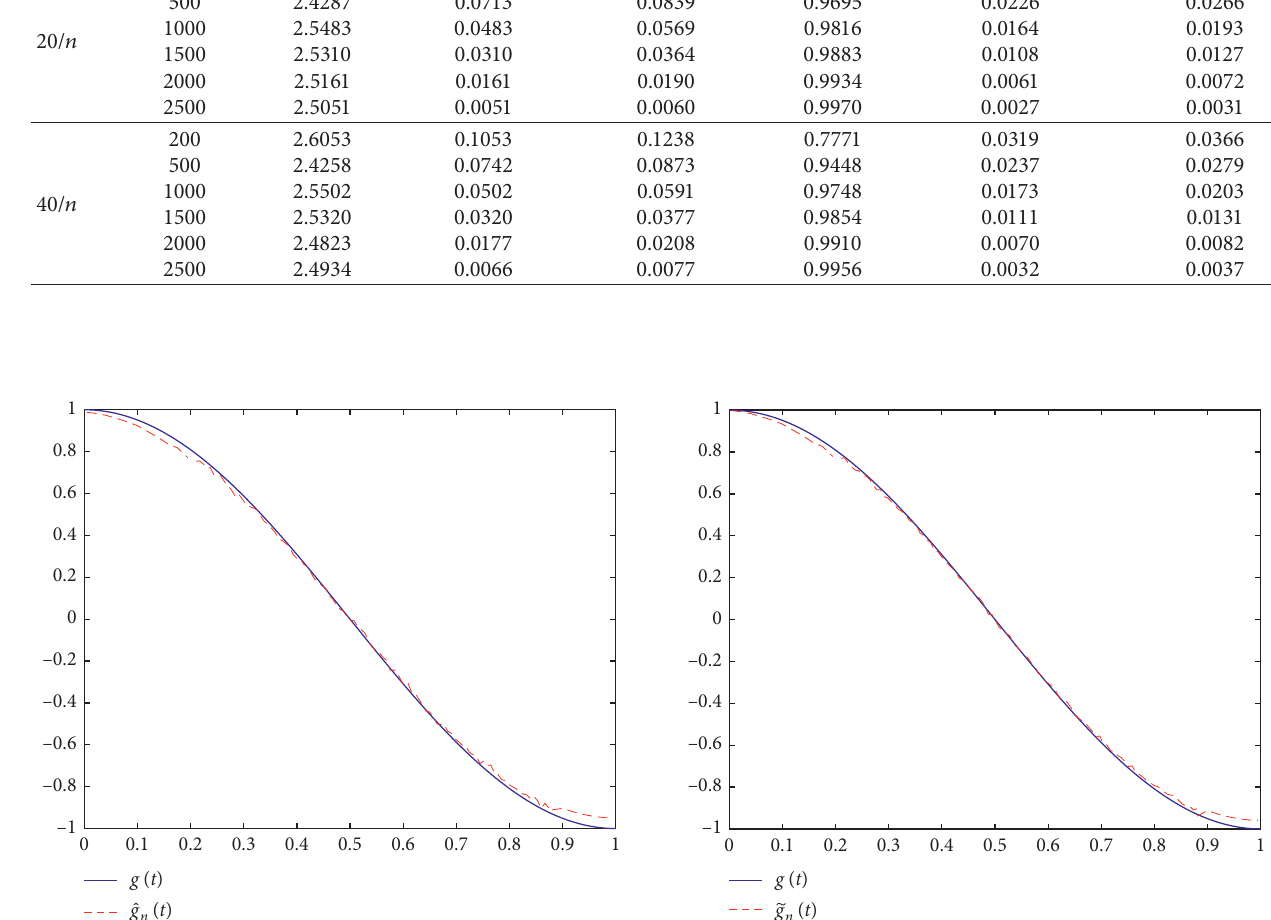
( t ) with β � 2 . 5 and n